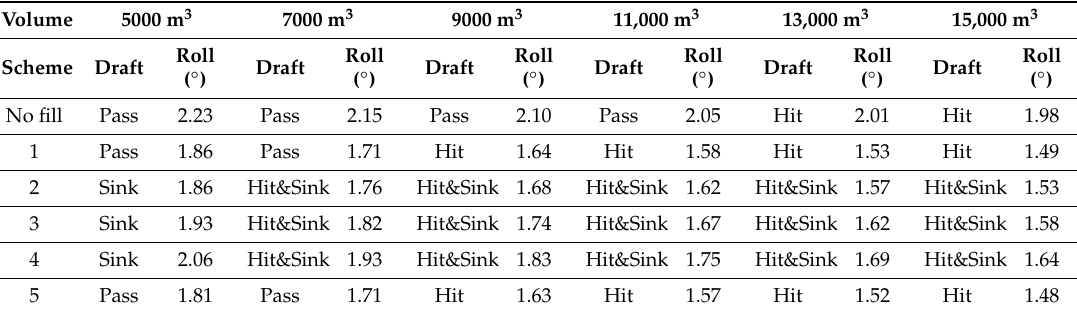
Table 6. Results of storage tank with D / H = 1.3, L / D = 1.05.